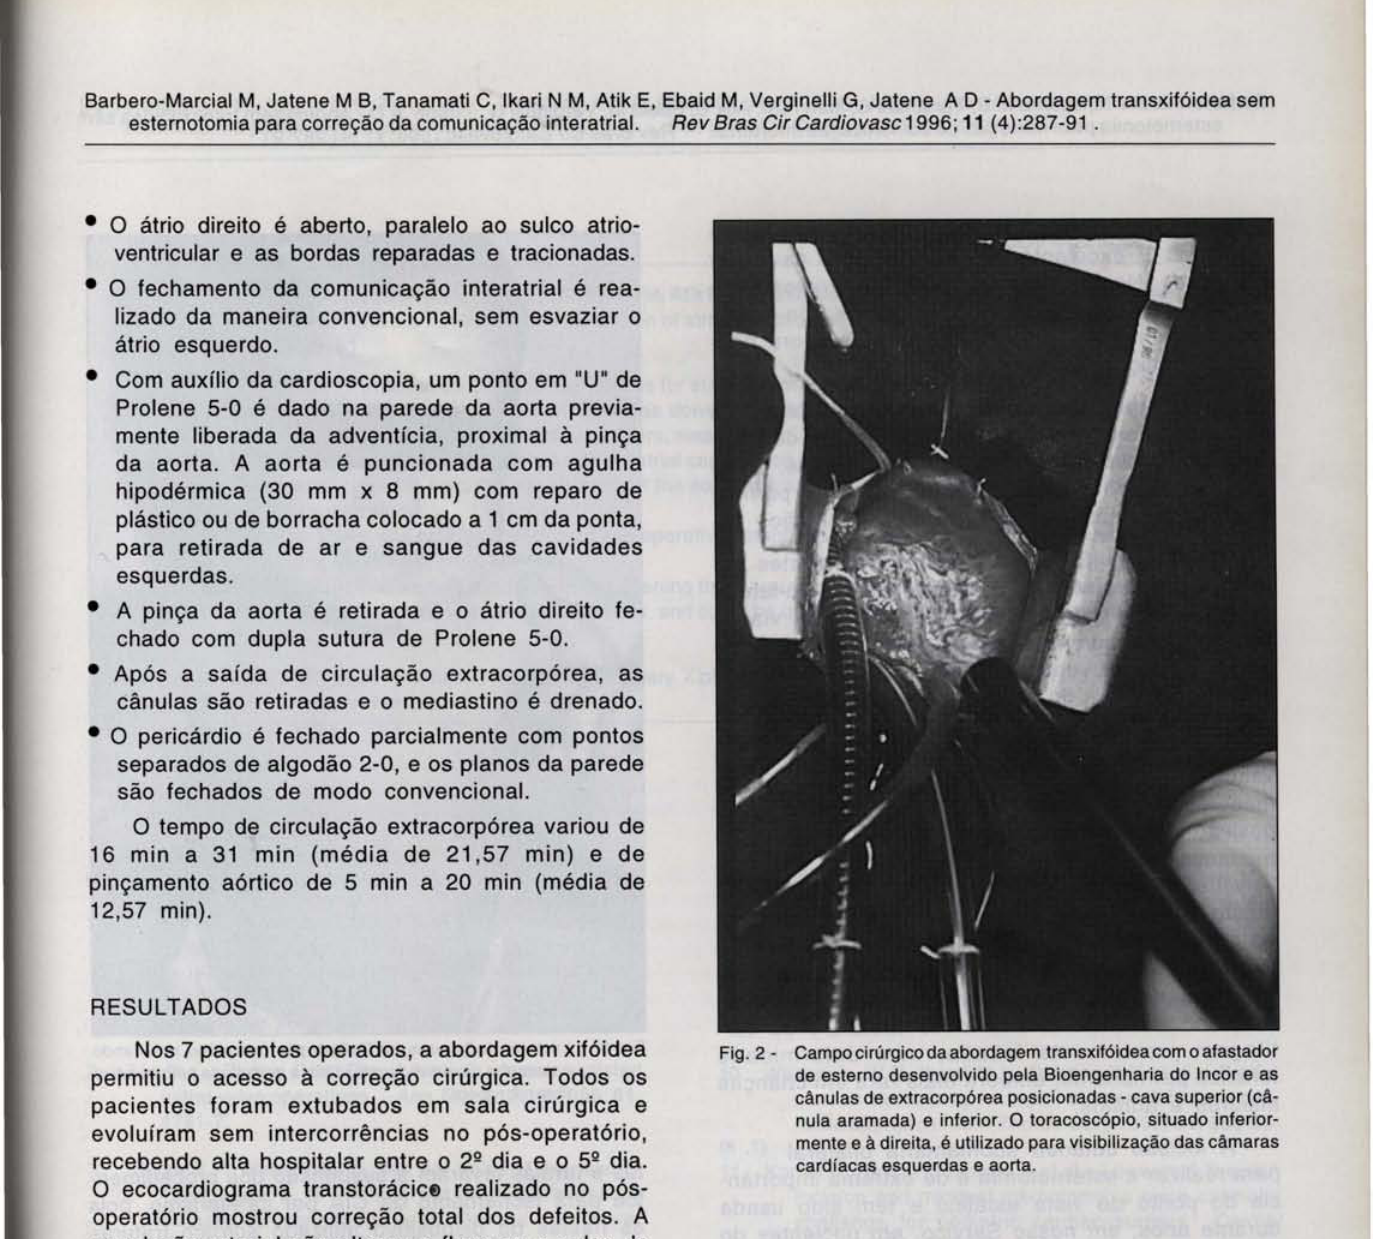
Fig. 2 - Campo cirúrgico da abordagem transxifóidea com o afastador de esterno desenvolvido pela Bioengenharia do Incor e